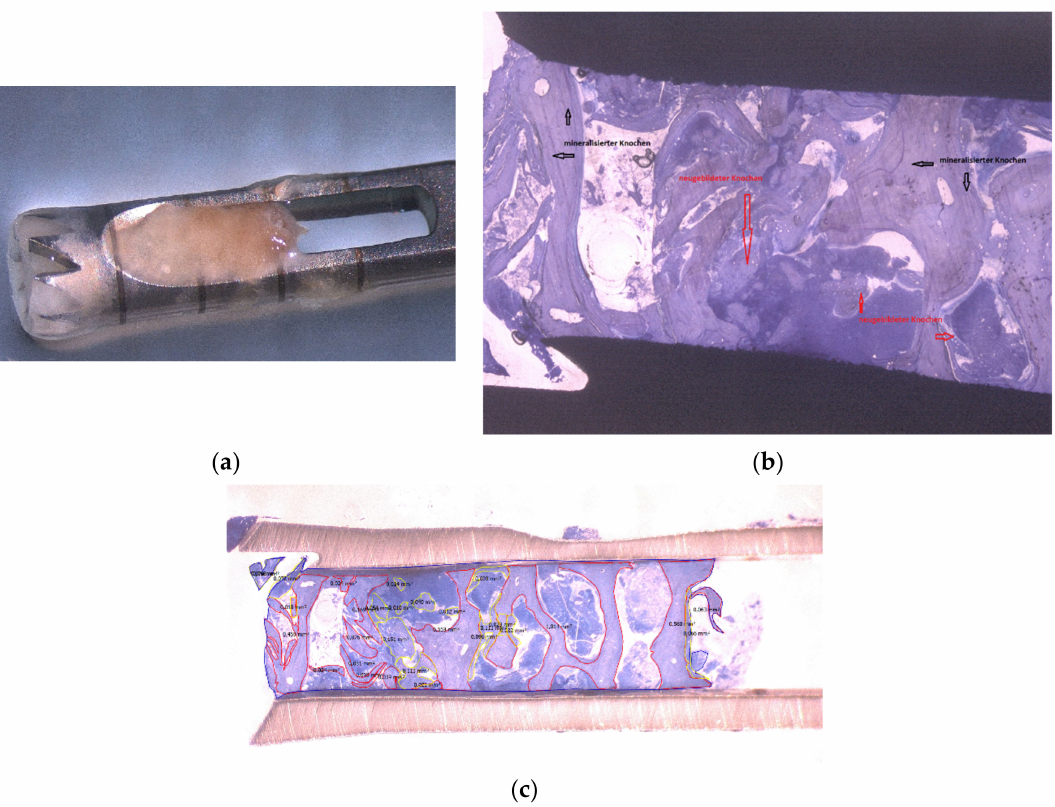
Figure 17. Trephine drill with bone biopsy ( a ) and histology photos ( b , c ). The results showed new bone formation (yellow) and structures of mineralized (ACCB) bone (red) after 6 months of healing, as expected.